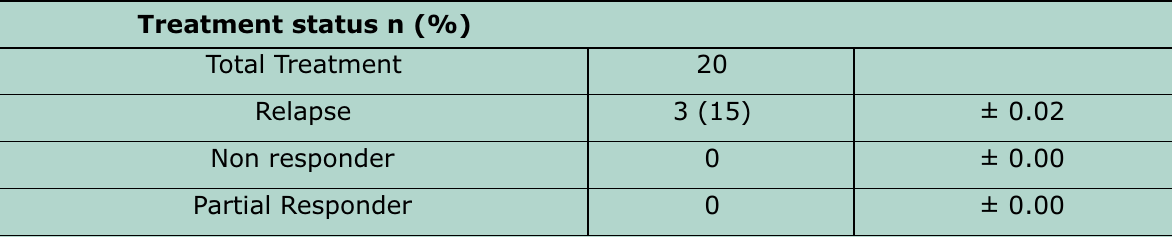
Table-III: Showing treatment status of the